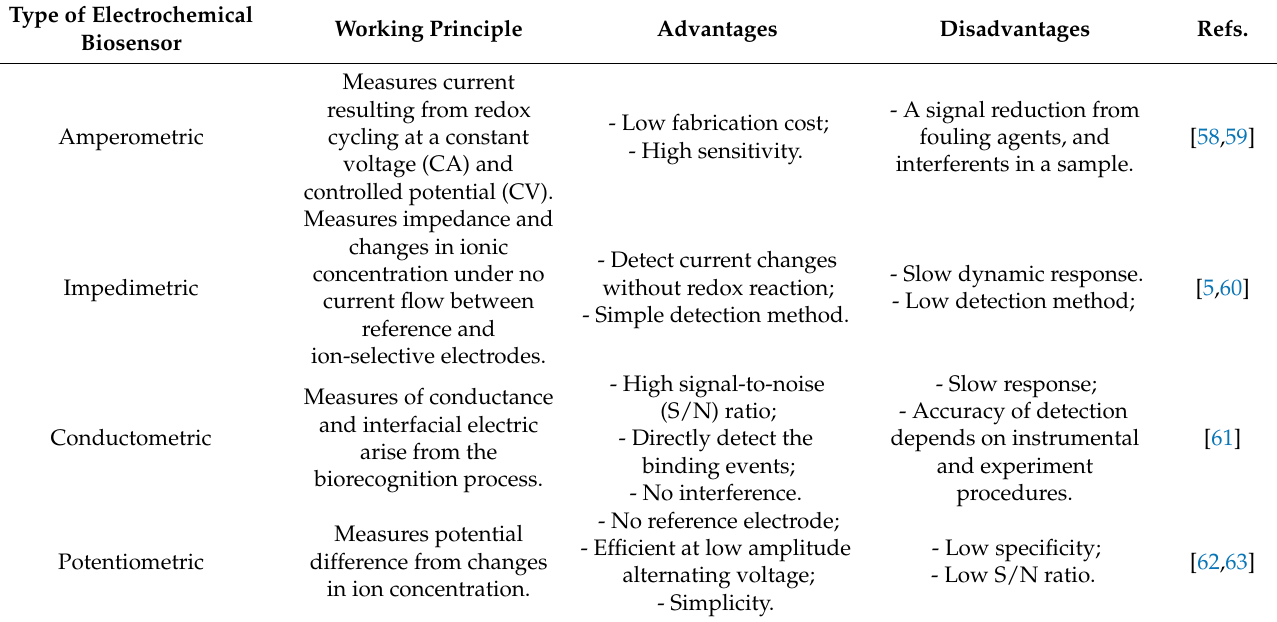
Table 1. The working principle of electrochemical biosensors and their advantages and